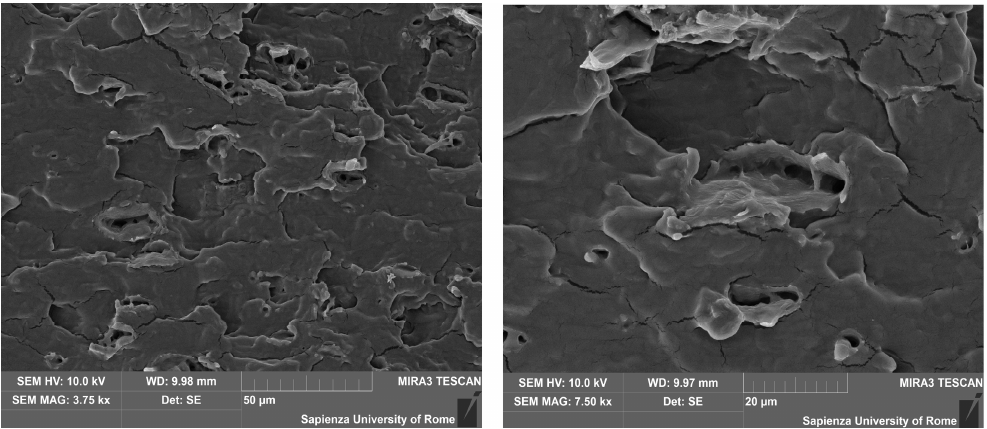
Figure 7. SEM images of the pure TPS fracture surface.